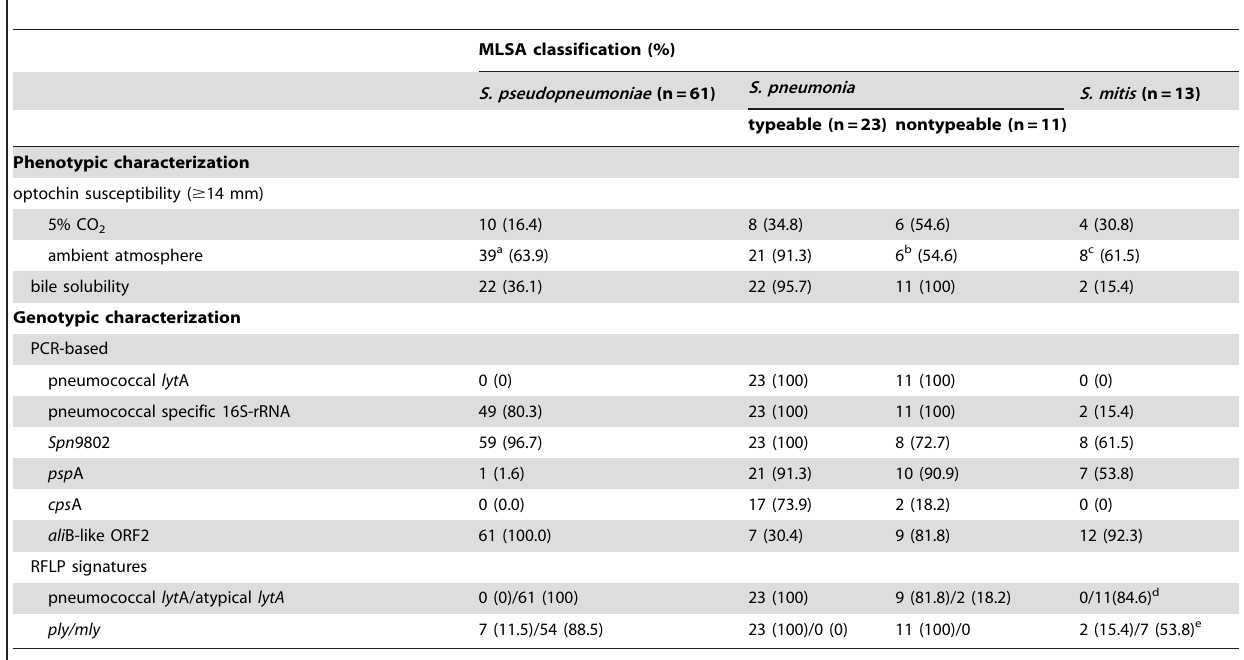
Table 1. Phenotypic and genotypic characterization of MLSA typeable isolates.